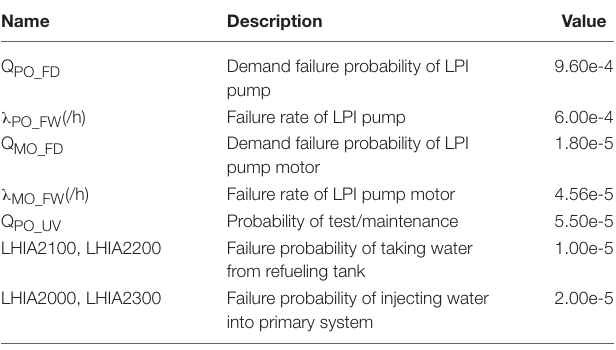
TABLE 7 | Parameters adopted in FTs for LPI system.